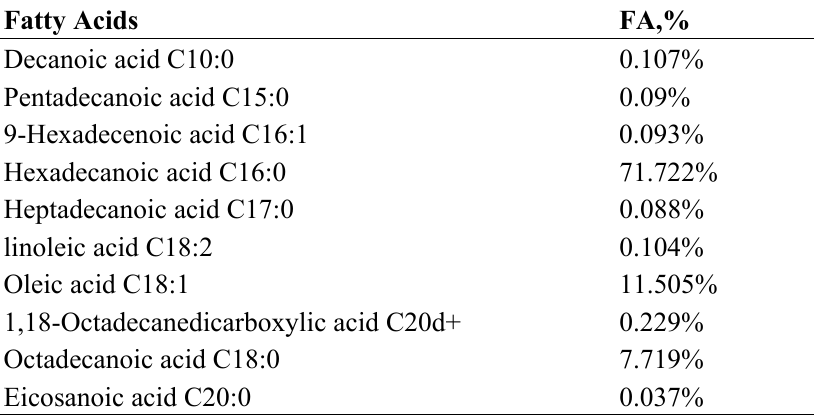
Table 4. Fatty acid composition after lacquer wax